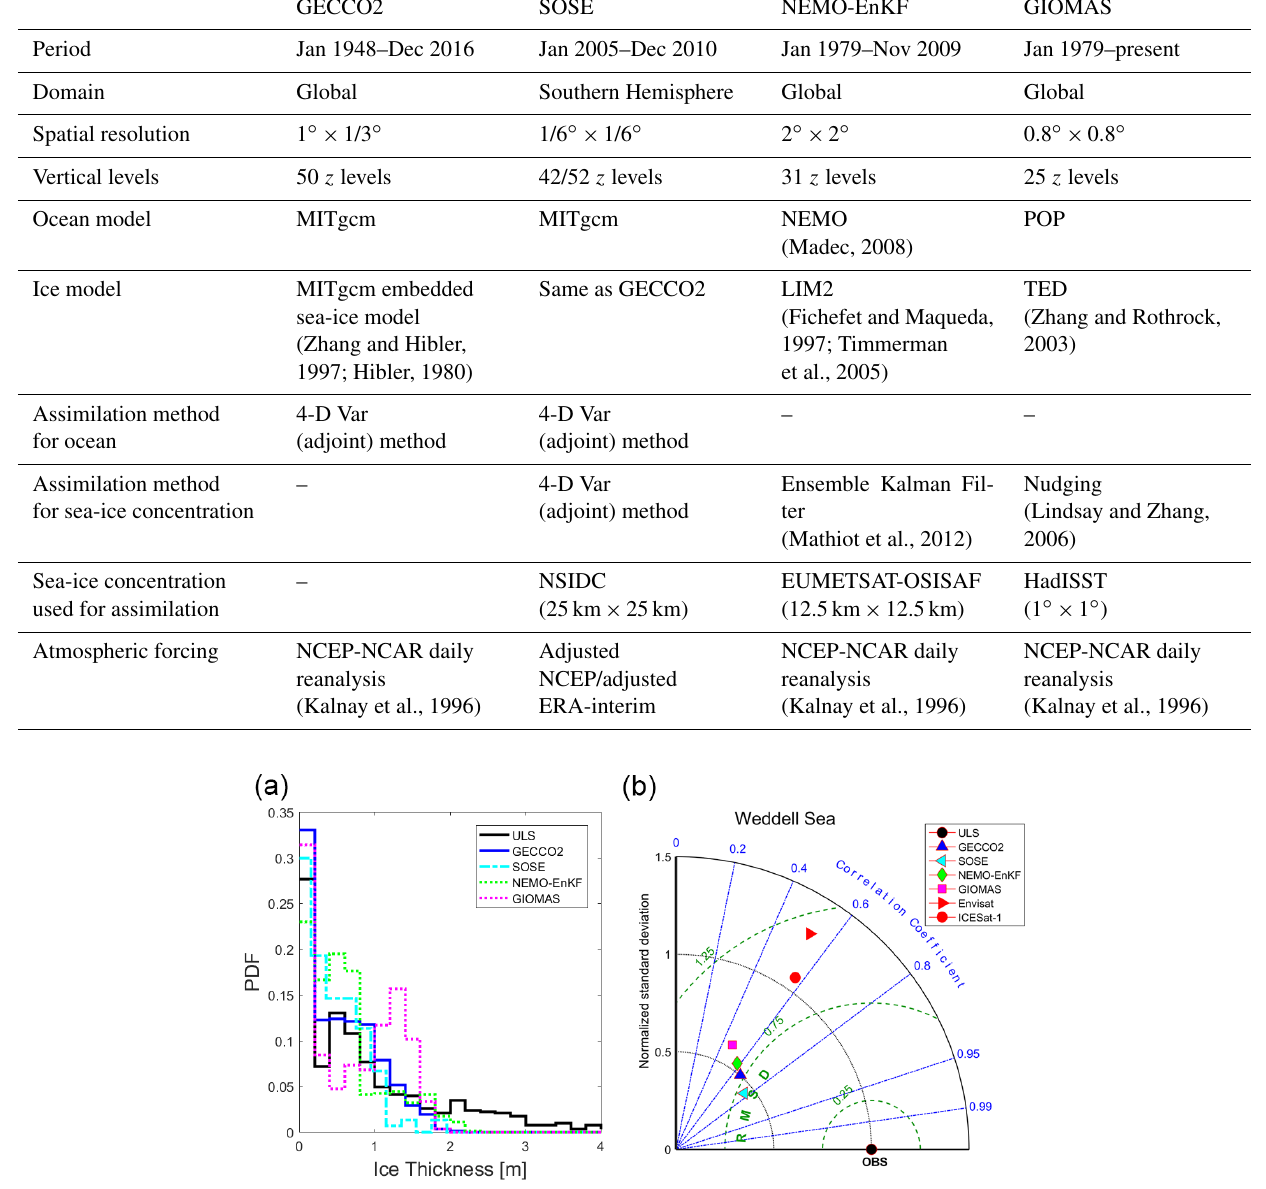
Figure 2. (a) Probability density distributions (PDFs) of monthly sea-ice thickness from ULS and the four reanalyses at the 13 ULS locations of the Weddell Sea. (b) Normalized Taylor diagram for monthly sea-ice thickness of the four reanalyses, as well as Envisat and ICESat-1, with respect to the sea-ice thickness from upward-looking sonar from 1990 to 2008 in the Weddell Sea. The dashed green lines indicate the normalized root mean square error